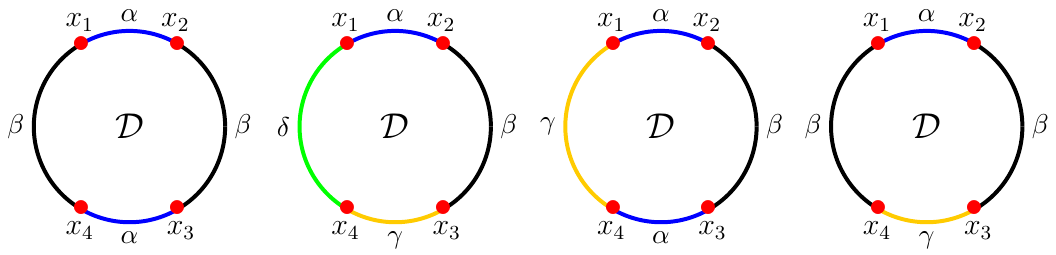
Figure 2 . Four boundary partition functions (from left to right) Z (cid:3) Di(cid:11)erent colors correspond to di(cid:11)erent (cid:12)xed boundary conditions for the (dual) Potts spin. The following relation holds Z (cid:3) linearly independent connectivities in (cid:12)gure 1, calculated with free boundary conditions. At